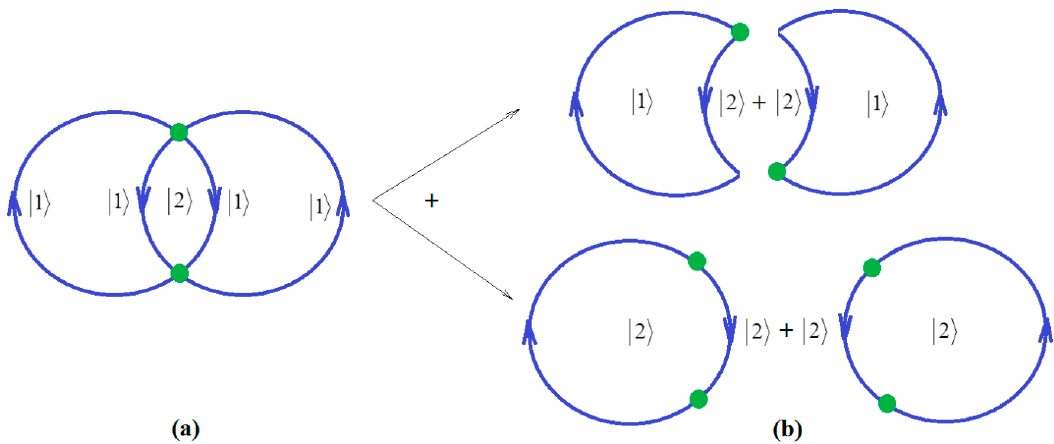
Figure 2. ( a ) The Bondonic graph of chemical bonding by electronic pairing formation; ( b ) The decomposition of bondonic graph as a superposition of active-holes and active hole-particles pairs,